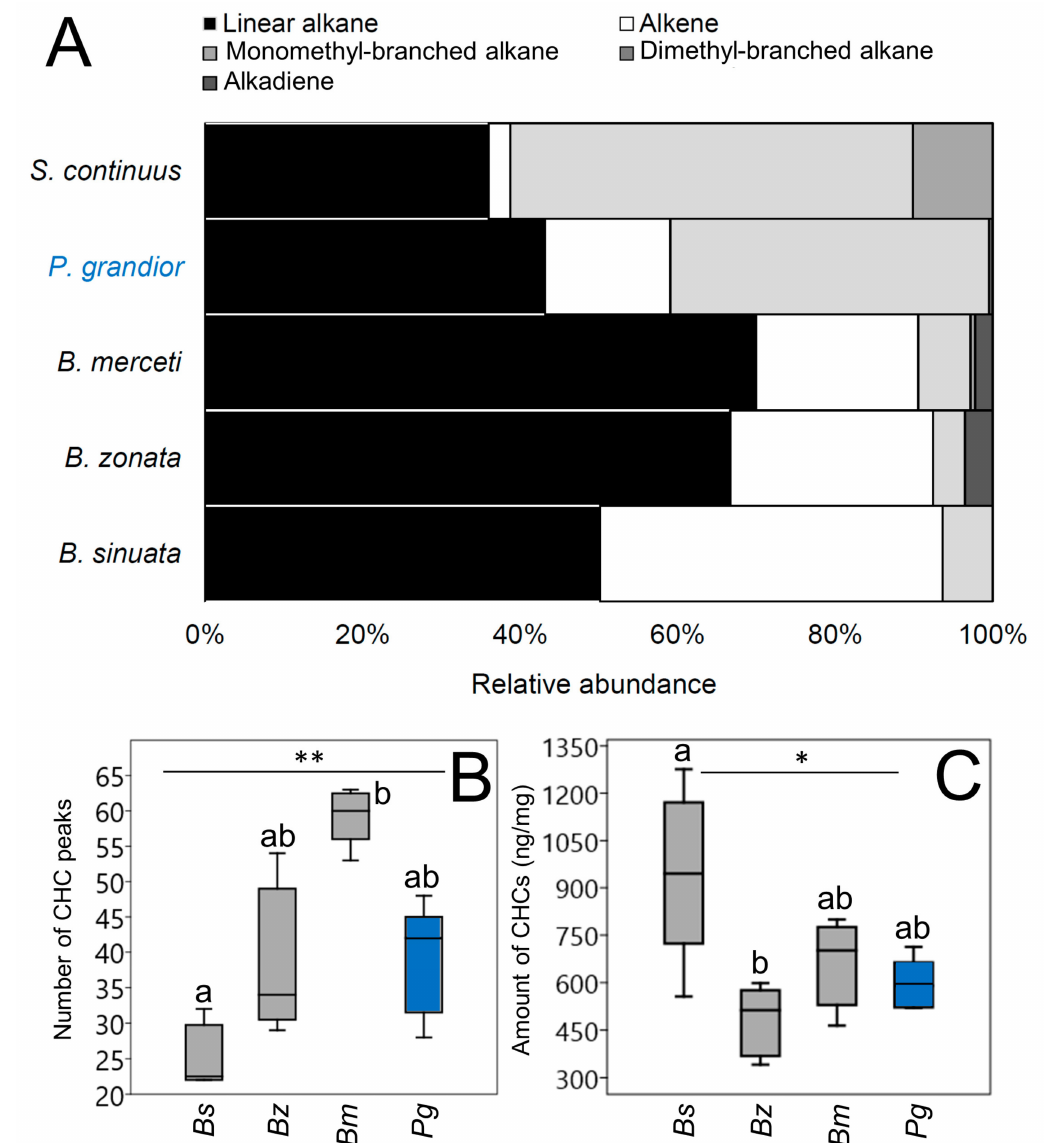
Figure 2. ( A ) Relative amount (in %) of the hydrocarbons substance classes in the cuticular hydrocarbon (CHC) profiles of P. grandior (in blue), its Bembix hosts and the non-host S. continuus (all in black); ( B ) Box-and-whisker plots showing medians (horizontal lines within boxes), 1 ◦ and 3 ◦ quartile (horizontal lines closing the boxes) and maximum and minimum values (ends of the whiskers) for the number of CHC peaks occurring in P. grandior and its Bembix hosts; ( C ) Box-and-whisker plots showing medians (horizontal lines within boxes), 1 ◦ and 3 ◦ quartile (horizontal lines closing the boxes) and maximum and minimum values (ends of the whiskers) for the amount of CHCs (nm / mg) on the cuticle of P. grandior and its Bembix hosts. * and ** mean that di ff erences among groups are significant at p < 0.05 and p < 0.01, respectively; letters identify pairwise di ff erences (Dunn’s procedure). Bs = B. sinuata , Bz = B. zonata , Bm = B. merceti , Pg = P. grandior